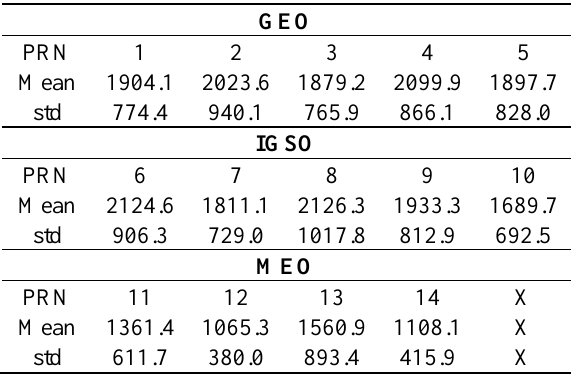
Table 6. BDS DQA4 statistical results.